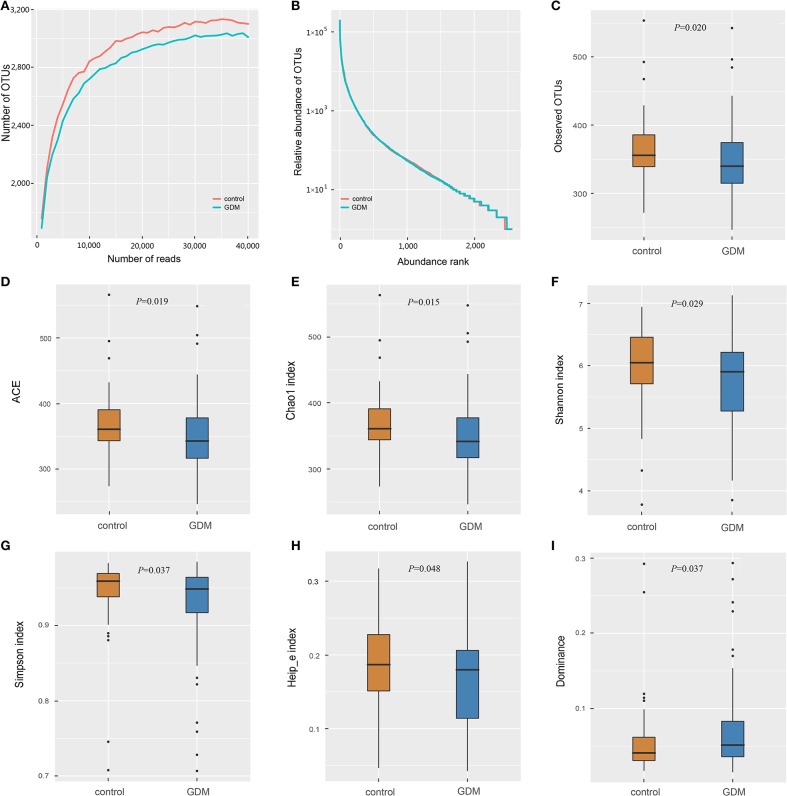
The richness and diversity of the gut microbiota in healthy control and GDM groups. (A) Rarefaction curves to estimate the richness of the gut microbiota in healthy control and GDM groups. The vertical axis shows the number of OTUs expected after sampling the number of tags or sequences shown on the horizontal axis. (B) Rank abundance curves of bacterial OTUs derived from the two groups. Alpha diversity was calculated with QIIME2 software (version 2018.11) based on the sequence similarity at the 100% level, including index of Observed OTUs (C), abundance-based coverage estimator (ACE, D), Chao1 estimator (E), Shannon (F), Simpson (G), Heip's evenness measure (Heip_e, H) and Dominance (I). Unpaired t-tests (two-tailed) were used to analyze variation among the two groups, and the P-values are shown in the corresponding figures.